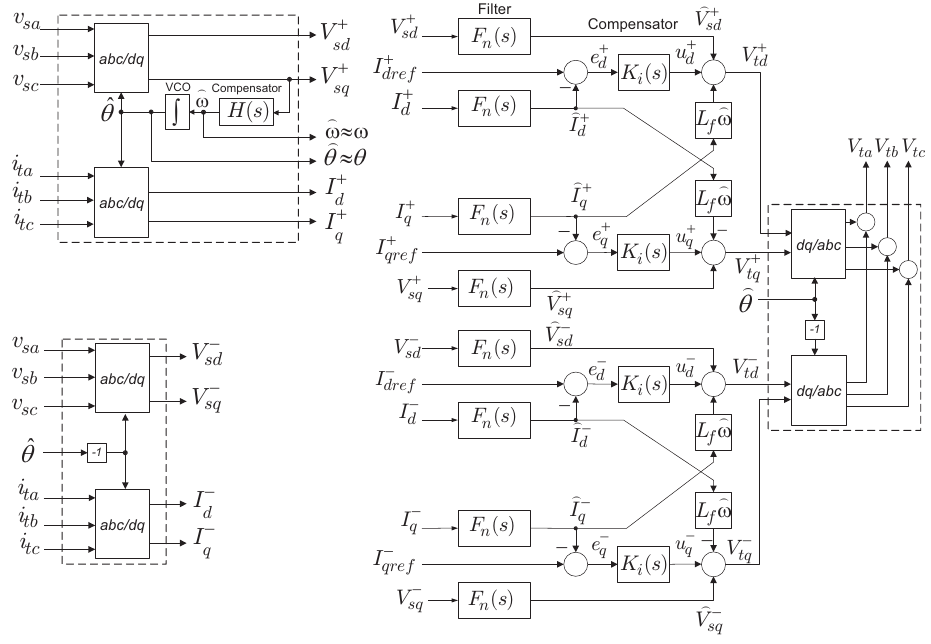
Figure 2. A schematic diagram of the conventional controller of